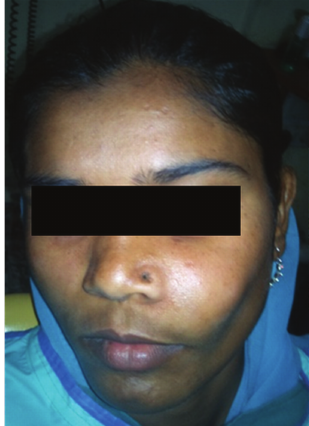
Figure 1: 16-year-old female with a swelling on the left cheek.